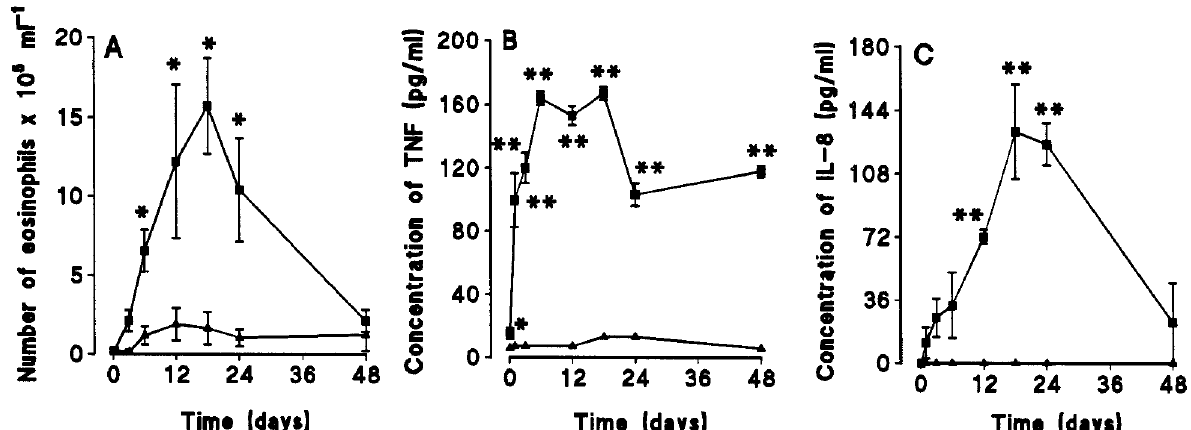
FIG. 1. Blood eosinophil counts (A) and serum TNF- a (B), and IL-8 (C) levels in T. canis -infected guinea-pigs sacrificed at different times post-infection ( n = 4–5 per day). Asterisks indicate a significant difference between infected ( j ) and non- infected animals ( m ). * P < 0.05 and ** P <